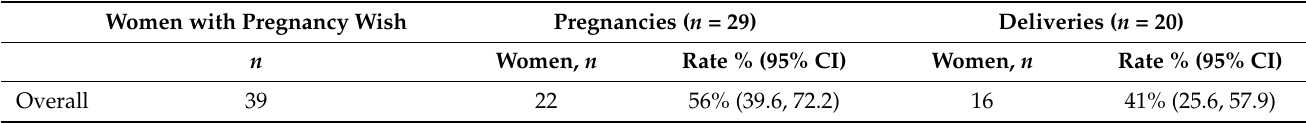
Table 2. Pregnancy and live birth rates in 39 women with a pregnancy wish.